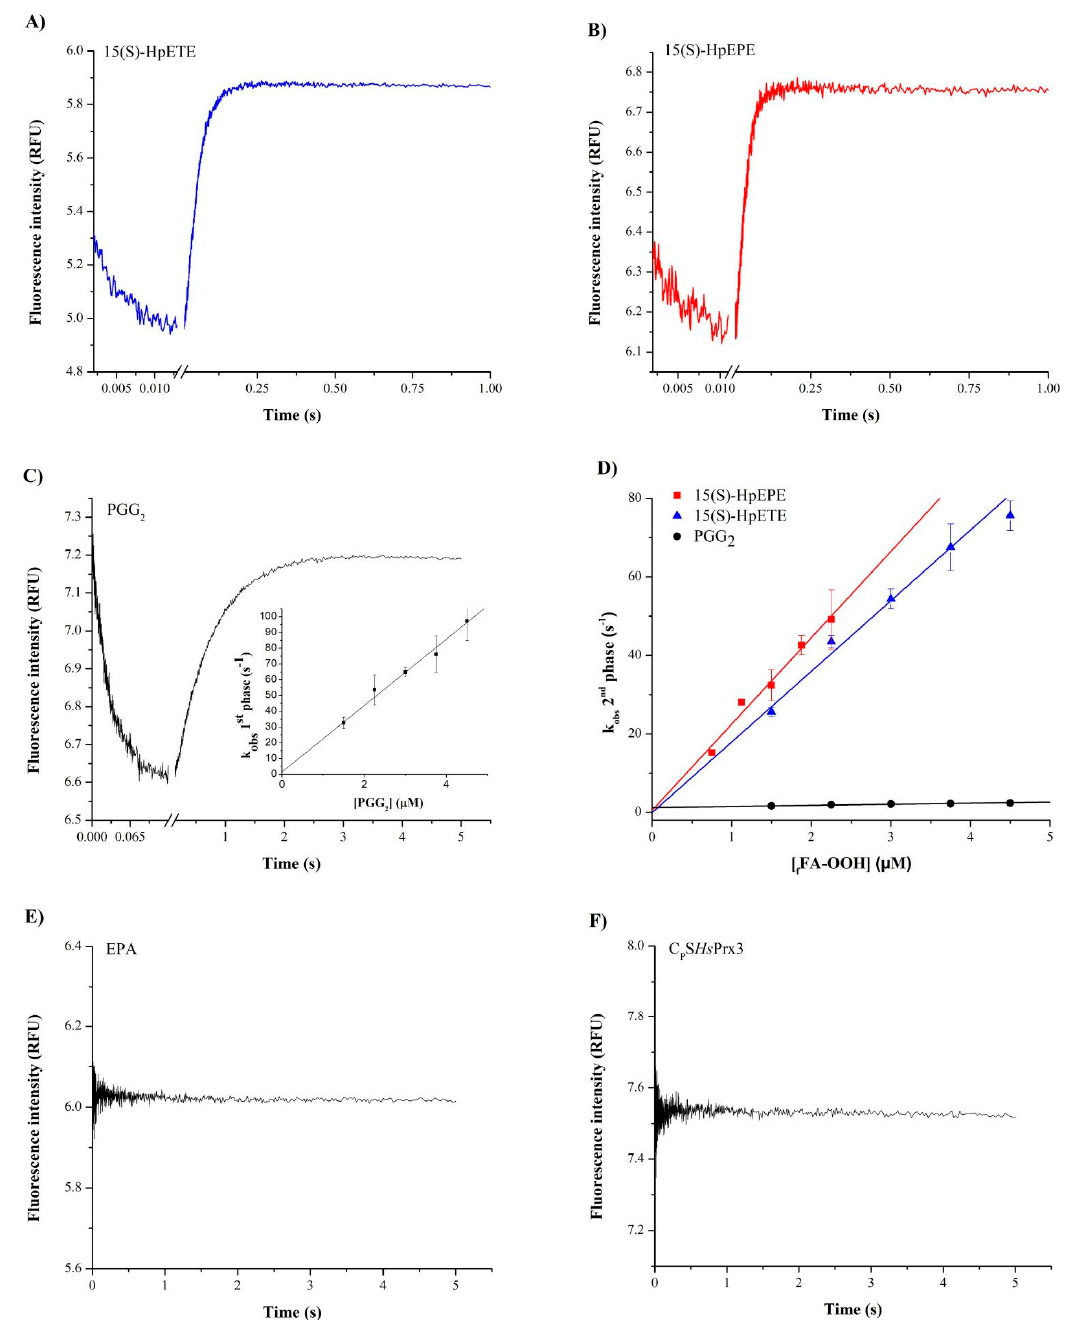
Figure 2. Kinetics of Hs Prx3 oxidation and hyperoxidation by f FA-OOHs. Reduced Hs Prx3 (0.3 µ M final concentration) was rapidly mixed with 15(S)-HpETE ( A ), 15(S)-HpEPE ( B ) and PGG 2 ( C ) (1.5 µ M final concentration) in sodium phosphate buffer 50 mM plus 0.1 mM DTPA at pH 7.8 and 12 ◦ C. The time courses of intrinsic fluorescence intensity change were followed ( λ ex = 295 nm, total emission). The inset of ( C ) shows a linear fit of k obs of fluorescence intensity decay plotted versus PGG 2 concentration from which the second order rate constant of Hs Prx3 oxidation by PGG 2 was obtained. The rate constant of hyperoxidation of Cys P was determined for the three f FA-OOHs mentioned above, plotting the k obs of the phases of fluorescence intensity recovery against f FA-OOH concentration ( D ). Both in inset of ( C ) and in ( D ) the symbols and error bars represent medians and standard deviations from at least 5 replicates of one of the three independent experiments performed. The effect of EPA (3 µ M) on the intrinsic fluorescence of reduced Hs Prx3 (0.3 µ M) ( E ) and of PGG 2 (0.3 µ M) on C P S Hs Prx3 (0.3 µ M) ( F ) are also